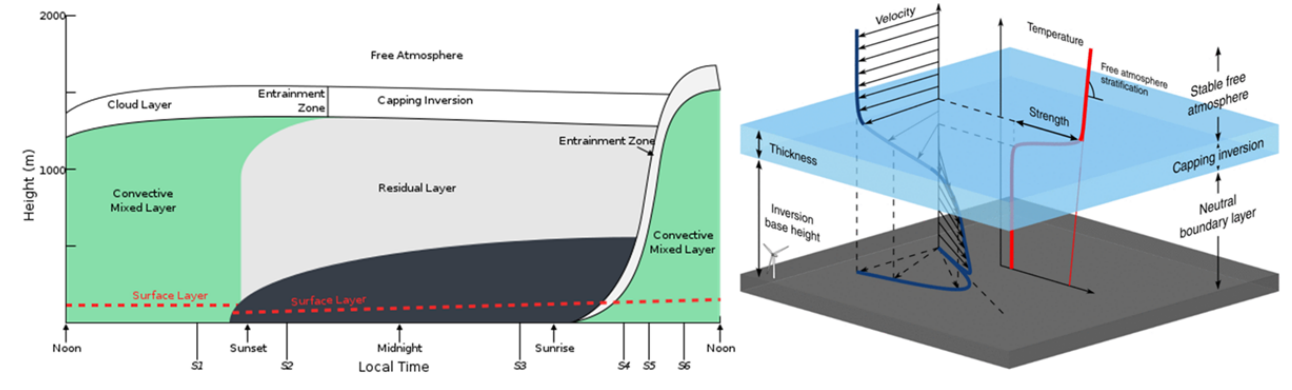
Figure 14. Planetary boundary layer